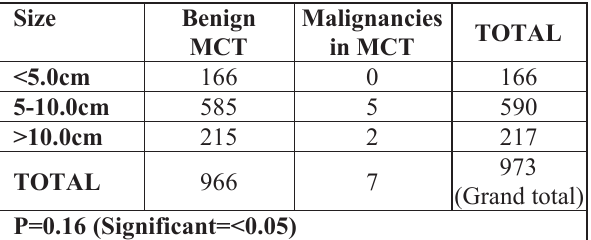
Table-6: Size correlation and Malignancies in MCT